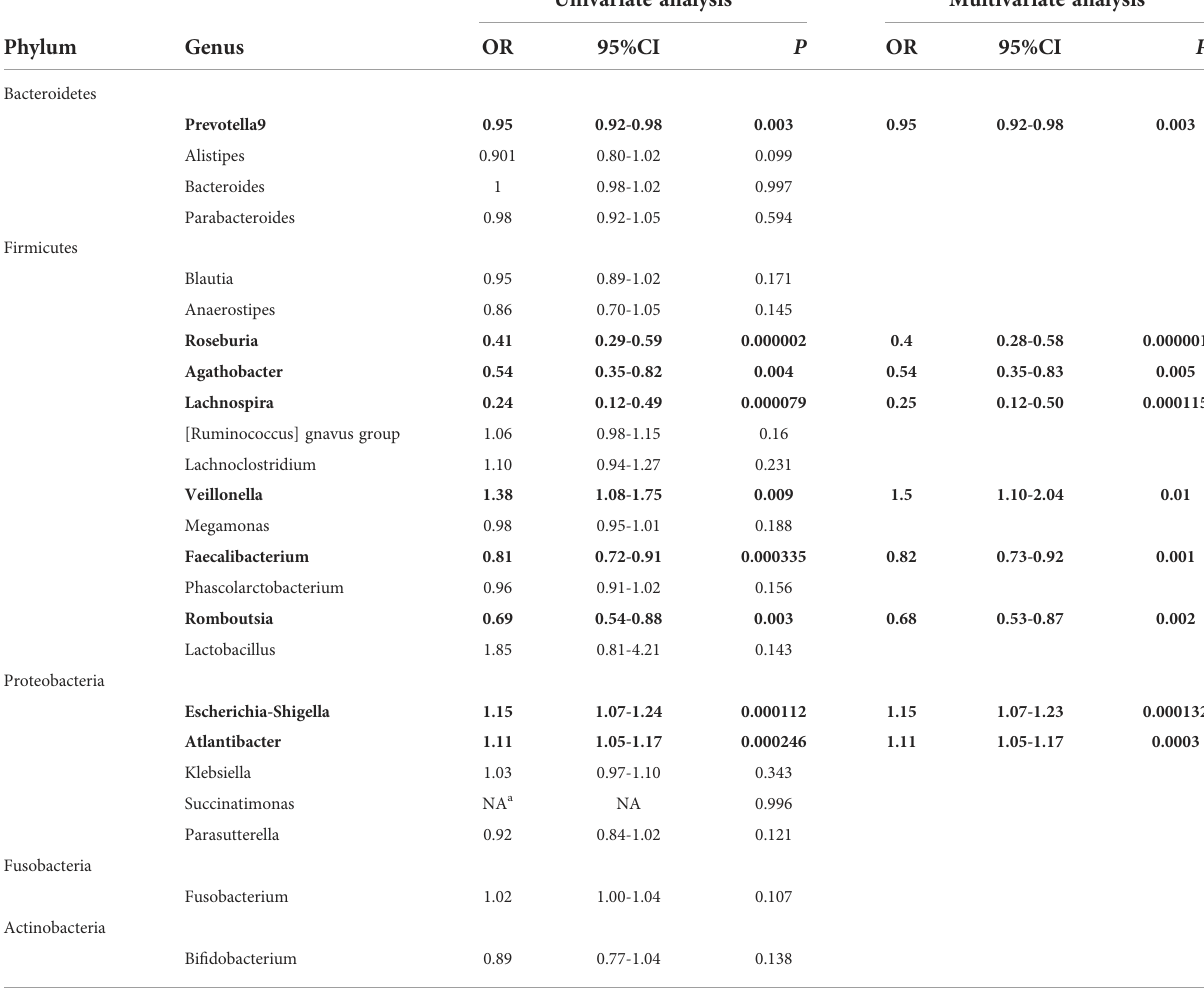
TABLE 3 Logistic regression analysis of the CD associated